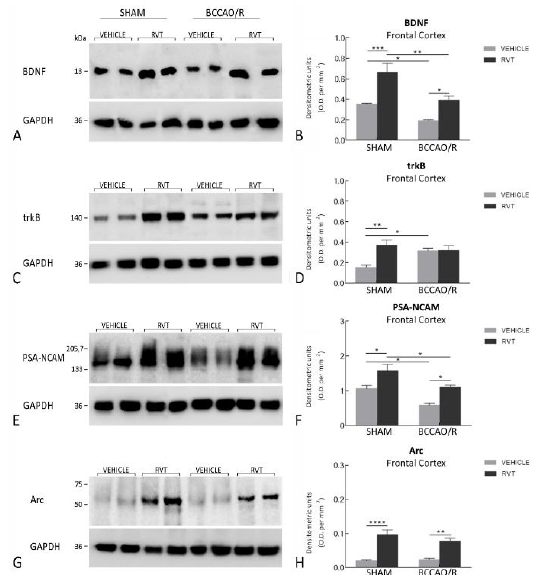
Figure 1. Western blot analysis of the frontal cortex homogenates in vehicle-treated and resveratrol (RVT)-treated rats either in sham-operated or after bilateral common carotid artery occlusion followed by reperfusion (BCCAO/R). ( A , B ) Brain-derived neurotrophic factor (BDNF), ( C , D ) tyrosine kinase receptor B (trkB), ( E , F ) polysialylated neural cell-adhesion molecule (PSA-NCAM), and ( G , H ) activity-regulated cytoskeleton-associated (Arc) protein. ( B , D , F , H ) Densitometric analysis of the band gray levels expressed as a percentage of the optical density (O.D.) ratio of BDNF-, trkB-, PSA-NCAM-, and Arc-positive bands to those immunostained for GAPDH. Data are reported as the mean values of 12 vehicle-treated and 10 RVT-treated rats. Error bars depict the standard error of the mean (S.E.M.). Asterisks denote significant differences. Two-way ANOVA with the Tukey’s test for post hoc analyses was applied to evaluate statistical differences between groups. * p < 0.05; ** p < 0.01; *** p < 0.001; **** p < 0.0001 (see Table 1 for F - and p -values relevant to effects of BCCAO/R and RVT pre-treatment and to the interaction between them).